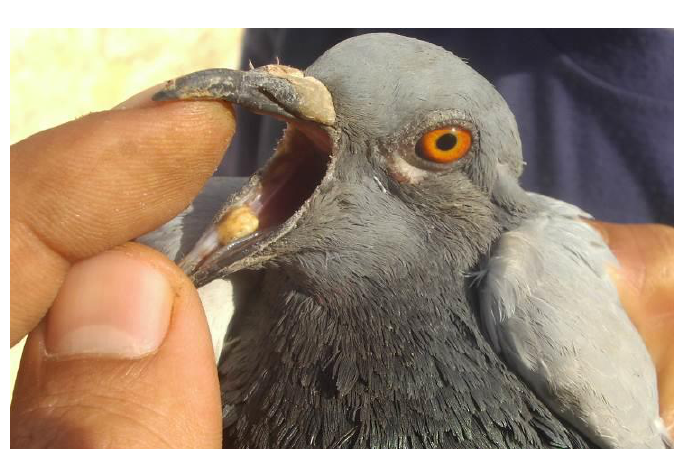
Figure, 1: characteristic lesion of trichomoniasis